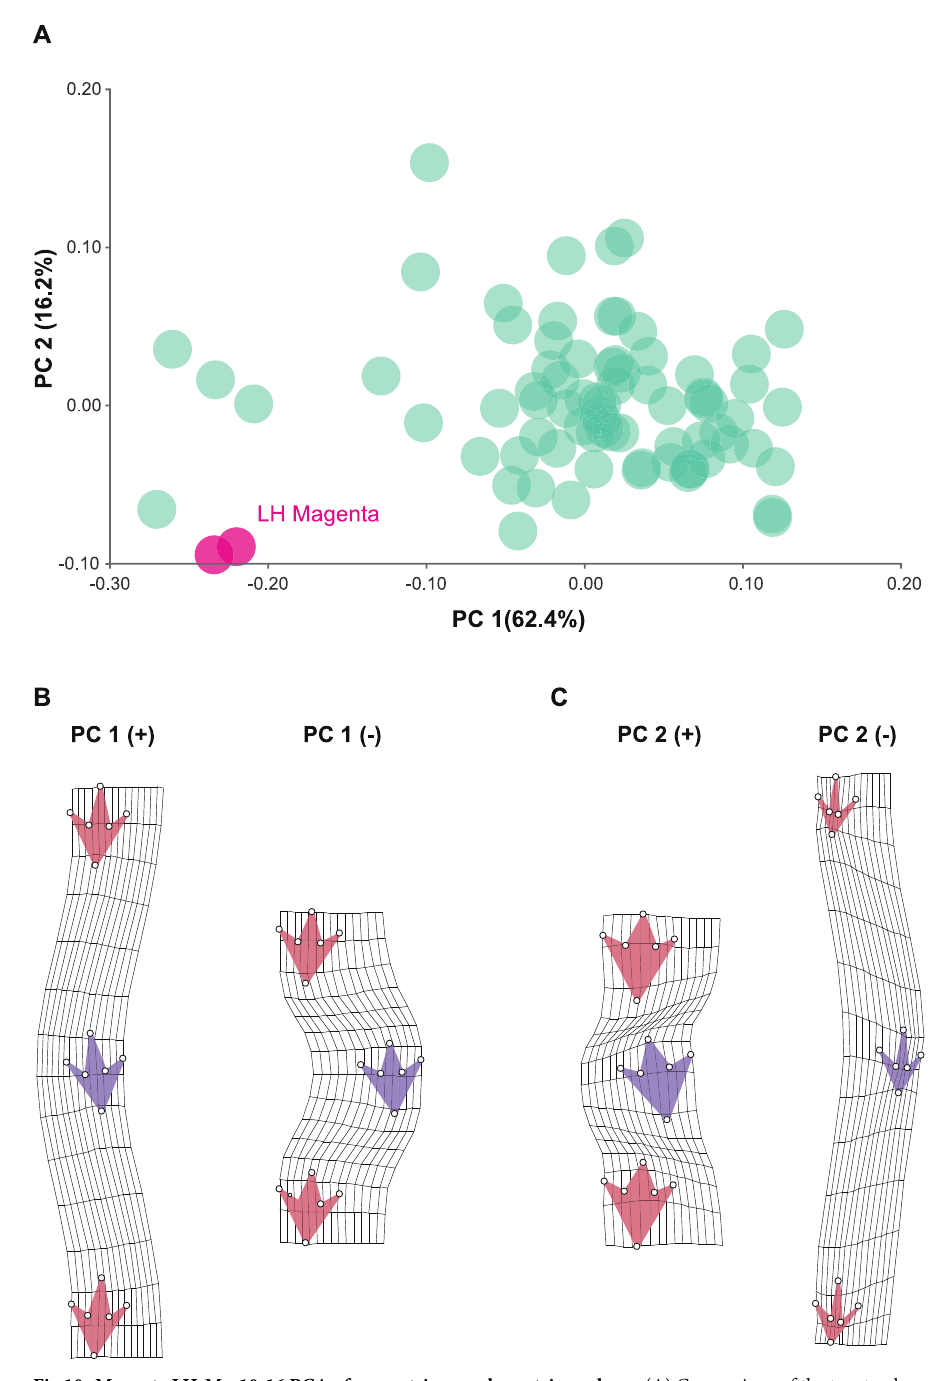
Fig 10. Magenta LH-Mg-10-16 PCA of geometric morphometric analyses. (A) Comparison of the two trackway subsets of Magenta with other bipedal dinosaurs worldwide. (B) Shape transformations in PC1 and (C) Shape transformation in